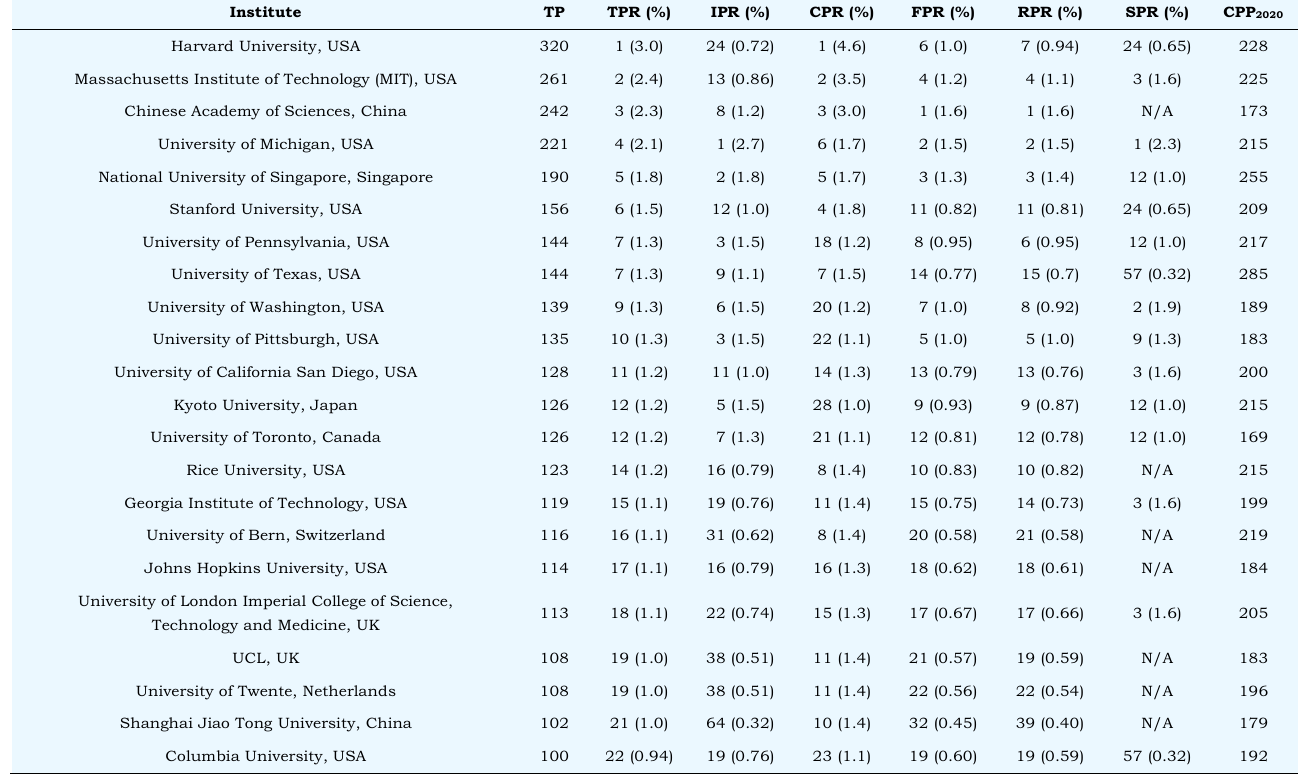
Table 4 Top 22 most productive institutes with 100 or more highly cited articles in the Web of Science Category of Biomedical